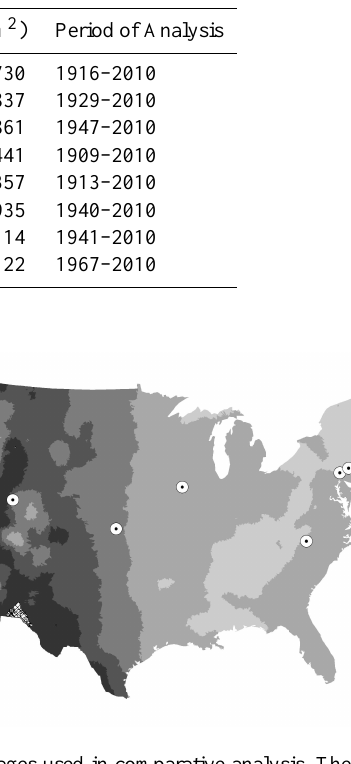
Fig. 1. Location of gages used in comparative analysis. The gages have been overlayed on a map of the aridity index (the ratio of an- nual potential evapotranspiration to annual precipitation). To repli- cate a teaching exercise for students, river gages have intentionally not been identified; it would be the task of the students to match the discharge data in Figs. 2 and 3 with the location markers in Fig.